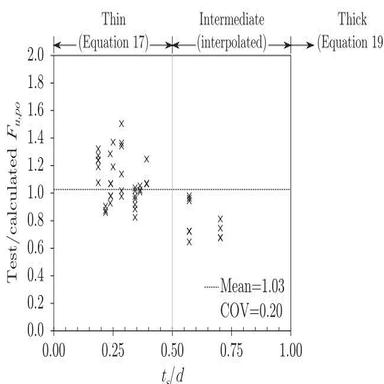
Comparisons between test and predicted Fu,po values for all screwed connections in plasterboard, calculated using Eurocode 5 , with Eq. for embedment strength and interpolation between critical values from Eqs. for cases when 0.5 < ts/d⩽1.0.